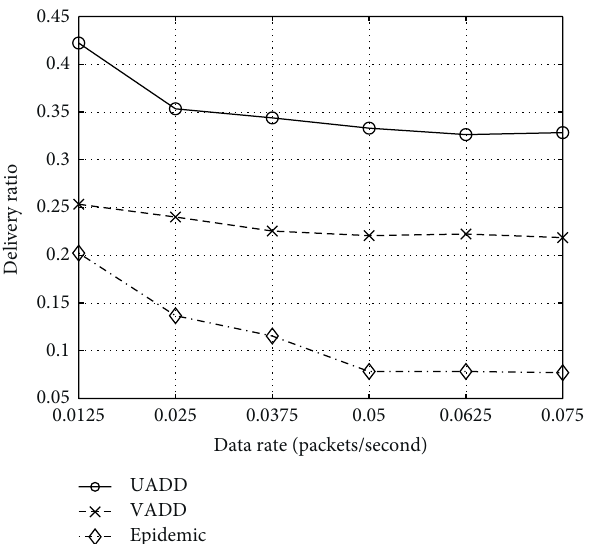
Figure 7: Delivery ratio. Buffers of vehicles are set to 50 packets. Figure 8: Average packet delivery delay. Buffers of vehicles are set to 50 packets.